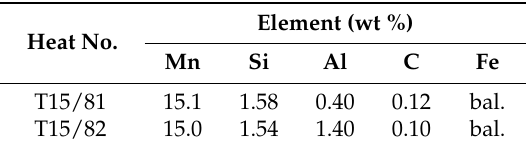
Table 1. The chemical composition of the experimental steel. Element (wt %) Heat No. Mn